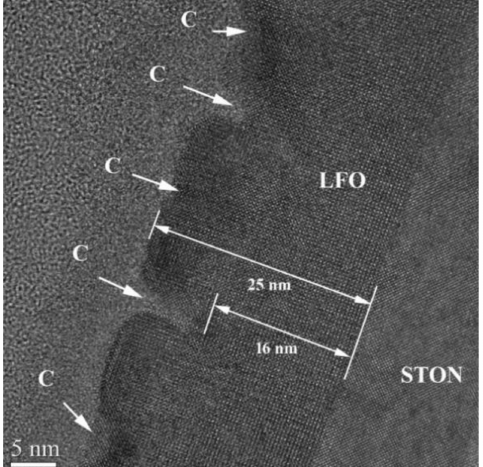
Figure 7. HRTEM images of LFO/STON sample with 15 nm thickness ( a ), corresponding to SAED pattern of the LFO film and the STON substrate in [100] orientation ( b ).